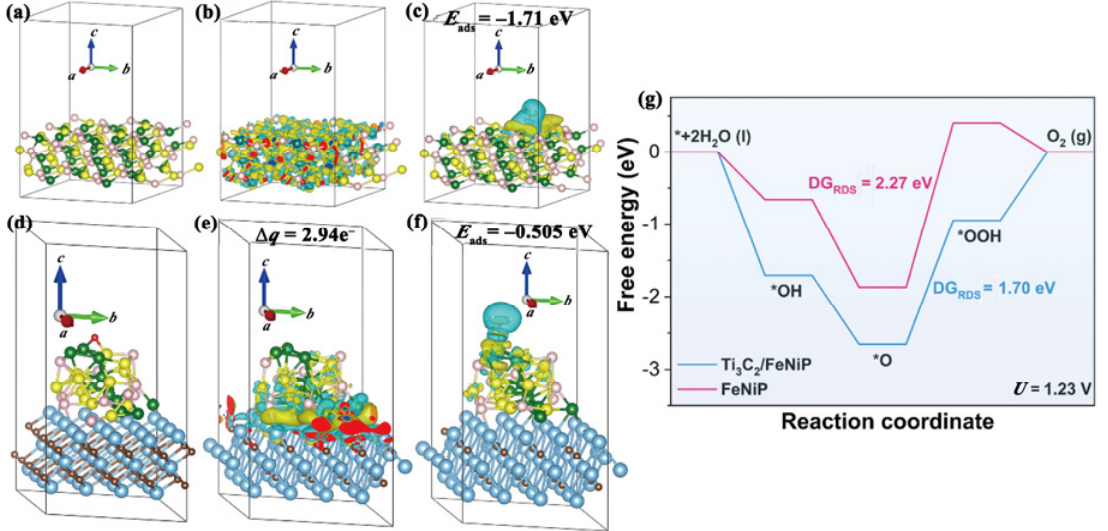
Fig. 5 Optimized structure of theoretical model for (a) FeNiP(111) and (d) MXene/NiFeP x (yellow: Fe, green: Ni, pink: P, blue: Ti, brown: C). Differential charge density maps of (b) NiFeP x , (c) NiFeP x –H 2 O, (e) MXene/NiFeP x , and (f) MXene/NiFeP x –H 2 O systems. The yellow and cyan isosurfaces show electron gain and loss, respectively. (g) Calculated OER free-energy diagrams of FeNiP(111) and MXene/NiFeP x where DG RDS is delta G RDS ( Δ G RDS ) which refers to the changes of Gibbs reaction free energy for rate-determining step